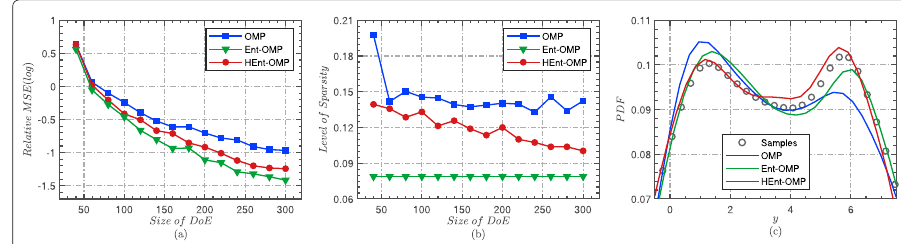
Fig. 2 Performance comparison of OMP, Ent-OMP and HEnt-OMP w.r.t. the Ishigami model. ( a ) The relationship between the relative MSE and the size of DoE; ( b ) The relationship between the sparsity level of several methods and the size of DoE; ( c ) Enlarged details of the reconstructed PDF